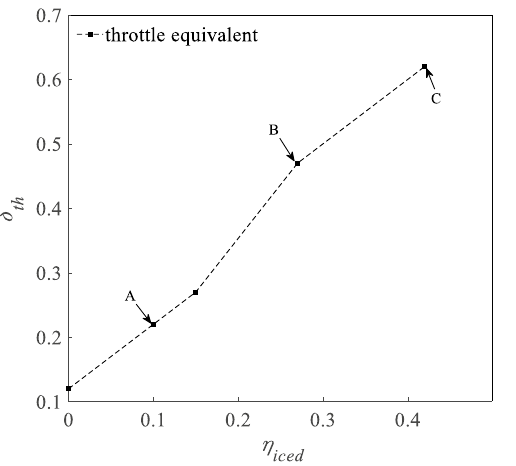
Figure 15. Balancing value of throttle equivalent.